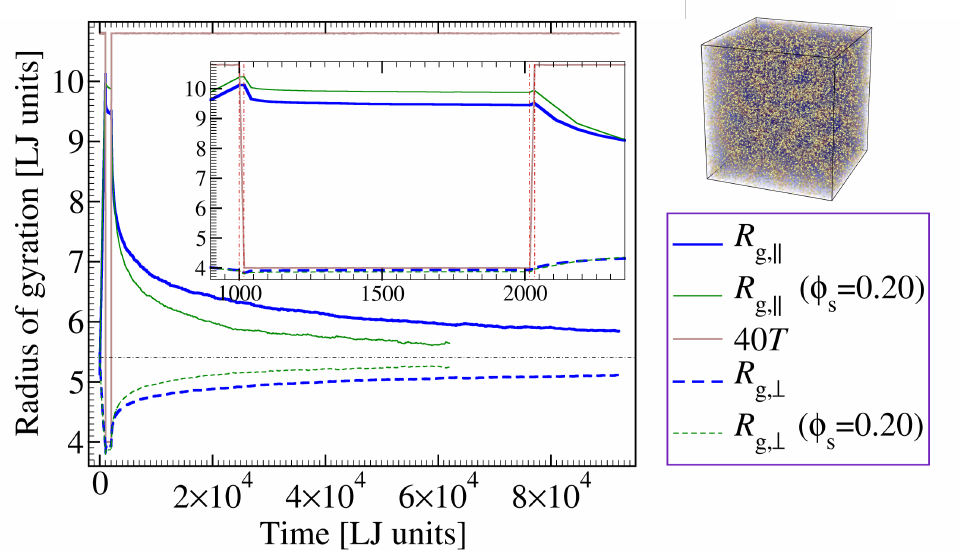
Figure 5. (Color online) Gyration tensor of polymer chains along the directions parallel ( (cid:107) , solid lines) and perpendicular ( ⊥ , dashed lines) to the direction of deformation. Thick blue lines correspond to a pure sample and green lines to a probe containing 20% additives with σ SS = 0.8. End of deformation is marked by the leftmost vertical line. After the cooling stage (between the 1st and 2nd vertical lines), L z is coupled to a barostat with p zz = 0. This leads to a small partial recovery, followed by a plateau (best visible in the inset) indicative of temporal arrest (shape fixation). As temperature raises above T g , chains become sufficiently mobile to acquire isotropic conformation and the probe relaxes to its original shape. The third and fourth vertical lines in the inset mark the beginning and end of the heating process. For better visibility, T is multiplied by a factor of 40. The upper right image is a snapshot of an undeformed configuration at T = 0.35 with 20% additive particles (yellow). Monomers (blue) are made